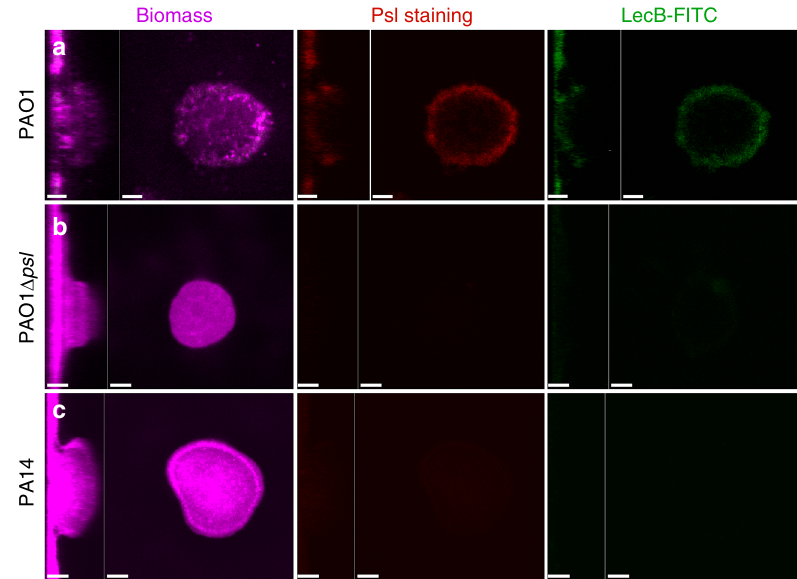
Fig. 4 LecB binds mature bio fi lms in Psl-rich regions. Exogenously added FITC-conjugated LecB binds to bio fi lms containing Psl. a PAO1 4-day-old bio fi lm stained with Syto 62 (magenta), HHA-TRITC (red), and LecB-FITC (green) showed that LecB binds to similar regions as HHA. b Although PAO1 Δ psl produces very few aggregates relative to PAO1, those that were found were negative for HHA and LecB staining. c The same was observed for a PA14 bio fi lm, which cannot produce Psl, but still makes Pel. Scale bars = 25 µ m